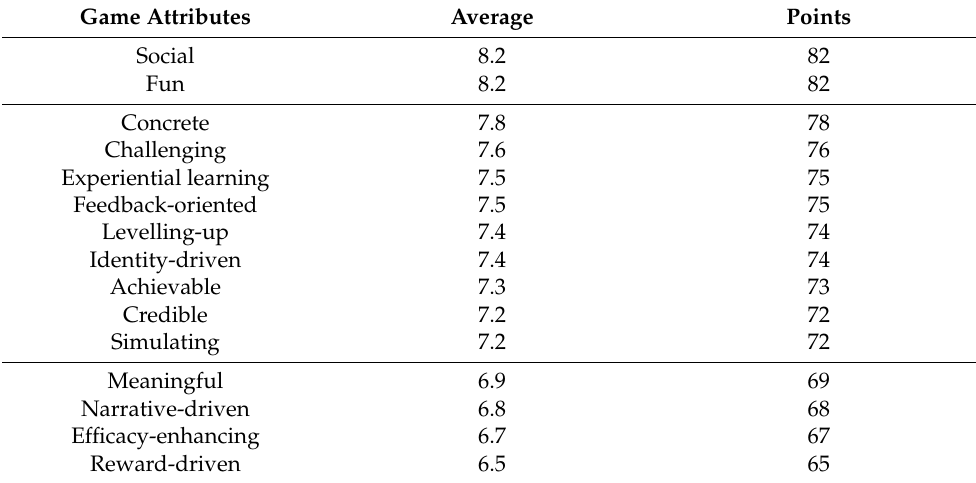
Table 2. Average score and points for each game attribute. Game Attributes Average